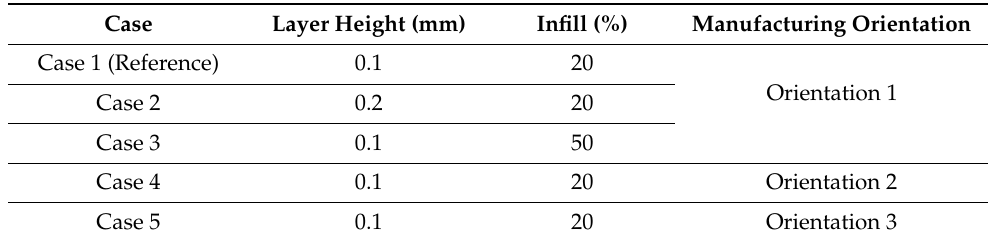
Table 4. The definition of case studies for a layer width of 0.4 mm, a printing velocity of 60 mm/min (30 mm/min on wall and bases), a line-type wall pattern, and infill patterns of 45 ◦ and 135 ◦ .